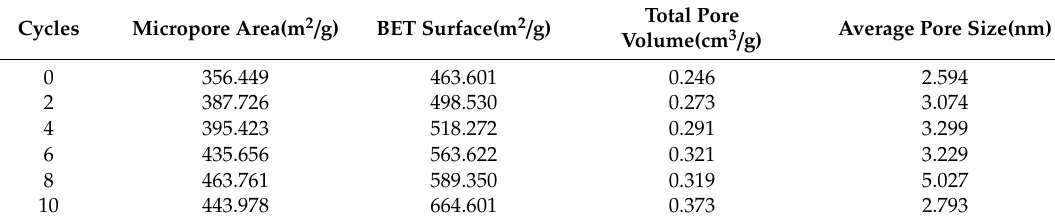
Table 2. Surface area and pore volume analysis.